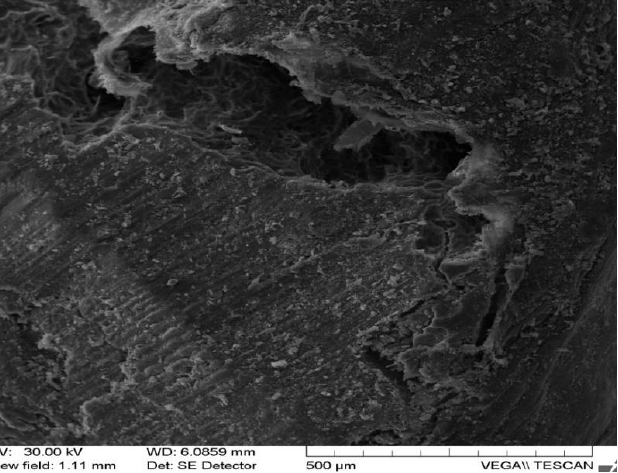
Figure 6. Area with new bone spans delimiting the gaps: numerous osteocytes (MTA) are present in their structure.